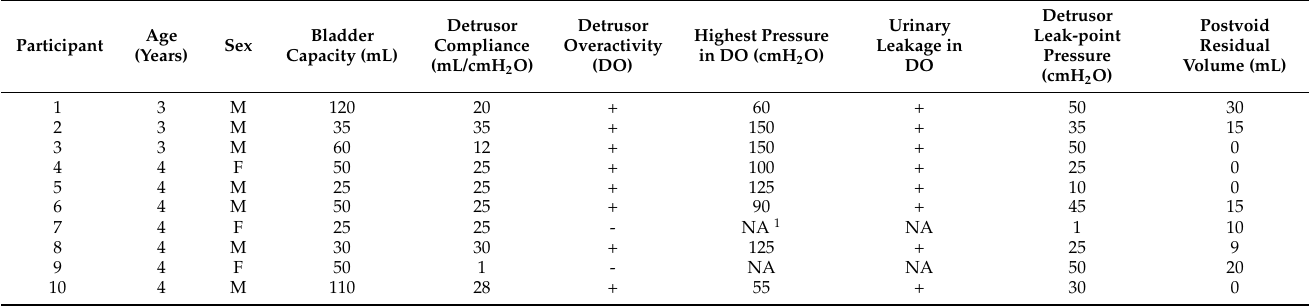
Table 2. Urodynamic parameters of 40 children undergoing UDS at OCUH-UPE from October 2018 to March 2020 as part of the